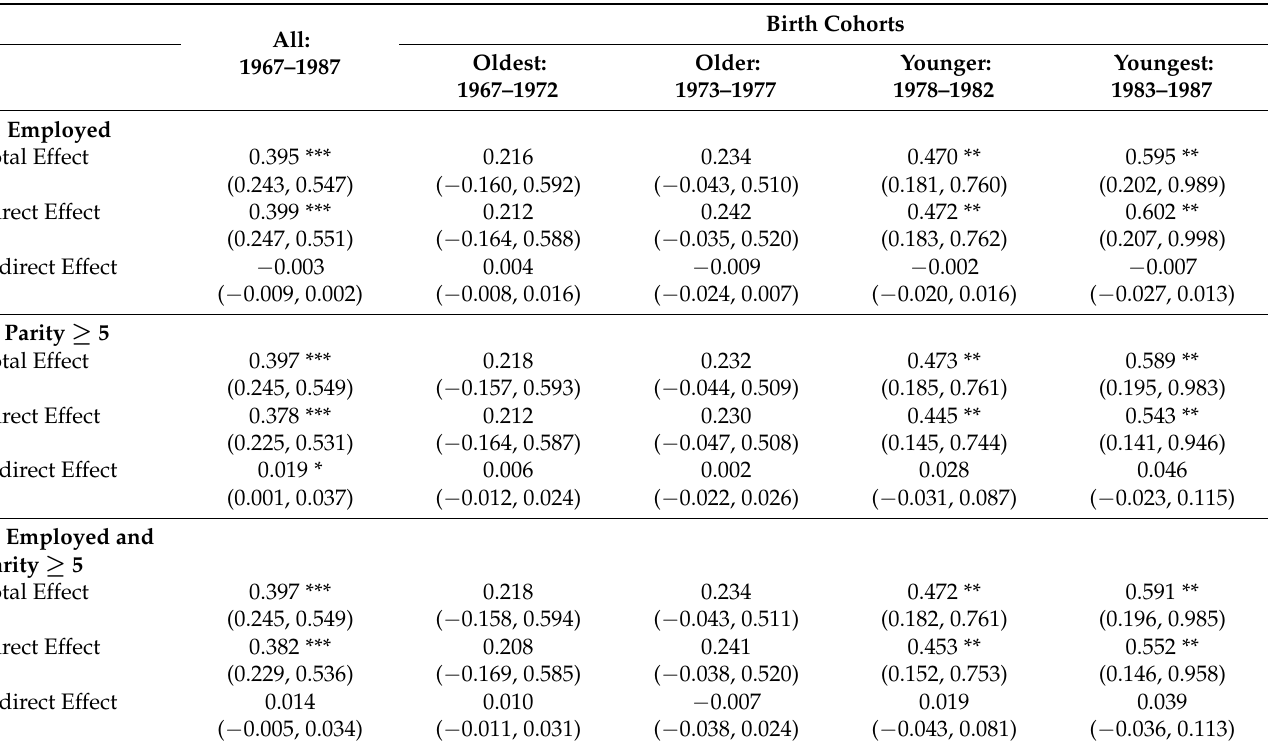
Table 6. Decomposition of total effect of child marriage into direct and indirect effect via employment status and high parity.